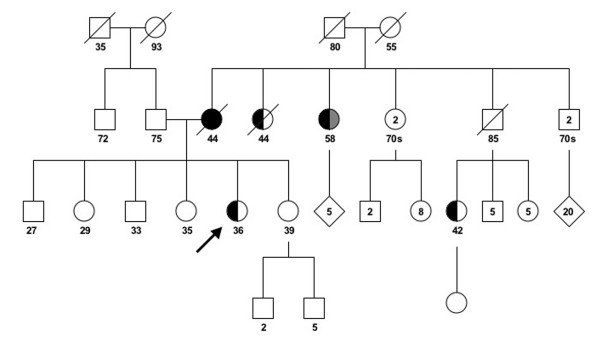
Pedigree of the patient (indicated by arrow). She, one maternal aunt and one maternal cousin had breast cancer diagnosed at 36, 44 and 41 years old, respectively, as indicated by the half-filled symbols, and her aunt died of the disease. Her cousin underwent lumpectomy followed by chemotherapy, radiotherapy and is presently on tamoxifen. Her mother had breast cancer in both breasts, diagnosed at ages 41 and 42, as indicated by the completely filled symbol. She underwent bilateral mastectomy and hysterectomy followed by chemotherapy and radiotherapy and died of the disease at age 44. A second maternal aunt was diagnosed with colon cancer at age 52 (light half-filled symbol) and breast cancer at age 55 (dark half-filled symbol). Based on this pattern of familial cancer the patient was considered to be at high risk of developing breast cancer and was entered into the low power MRI screening validation and feasibility study. Following her diagnosis, she was confirmed as carrying a Q1200X mutation in the BRCA1 gene.